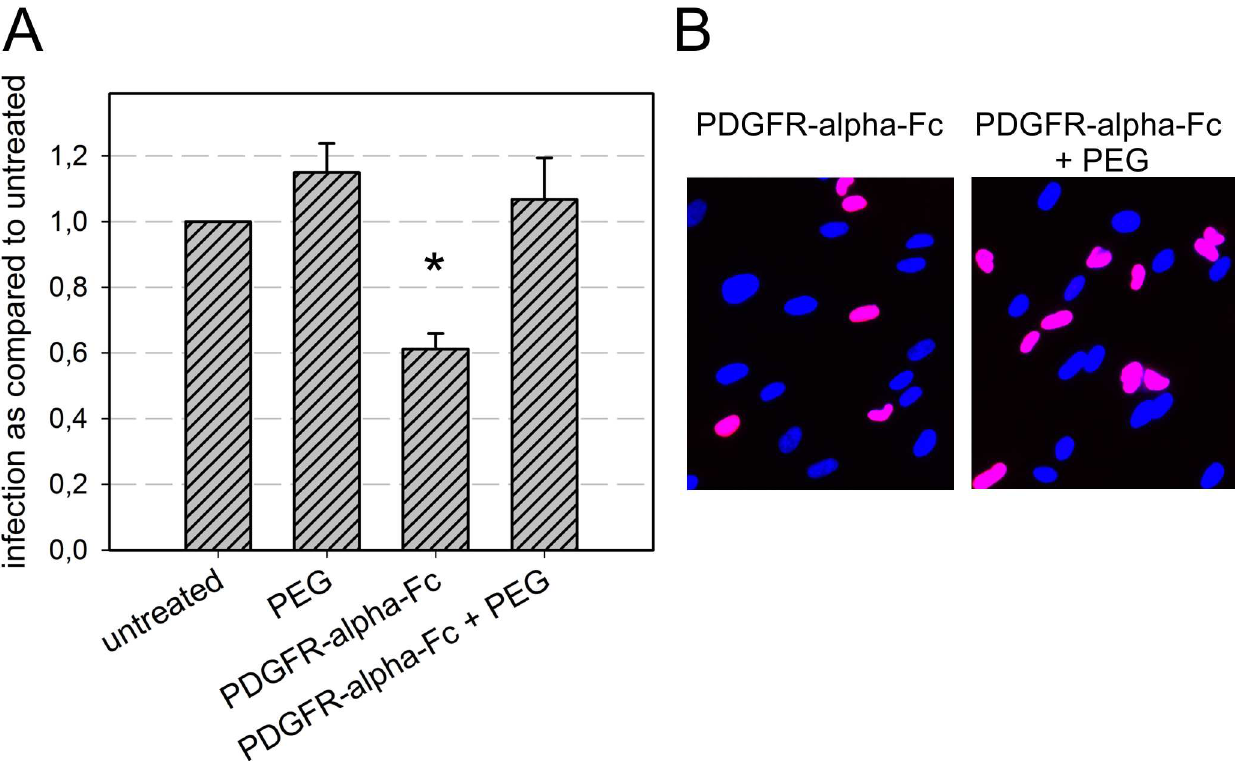
Fig 7. Postadsorption-inhibitory effect of soluble PDGFR-alpha-Fc. Virus preparations were adsorbedto fibroblasts on ice for 60 min and subsequently incubatedwith 200 ng/ml PDGFR-alpha-Fc for two hours on ice. Cells were then either directly shifted to 37˚C or first treated with the chemicalfusogenPEG. After an overnightincubation, cells were fixed and stained for viral IE antigens. (A) For each condition,the fraction of infected cells (immediate-early antigenpositive cells/total cells) was comparedto the untreatedcontrol. Mean values of 3 independent experiments are shown. Error bars indicate the standarderror of the mean (SEM). The significantdifference betweenPDGFR-alpha-Fc-treated cells and the untreatedcontrol is indicatedby an asterisk. (B) Examples of HCMV IE antigenexpression(red fluorescence) after treatment with PDGFR-alpha-Fc alone or PDGFR-alpha-Fc and PEG. Nuclei were counterstained with DAPI.